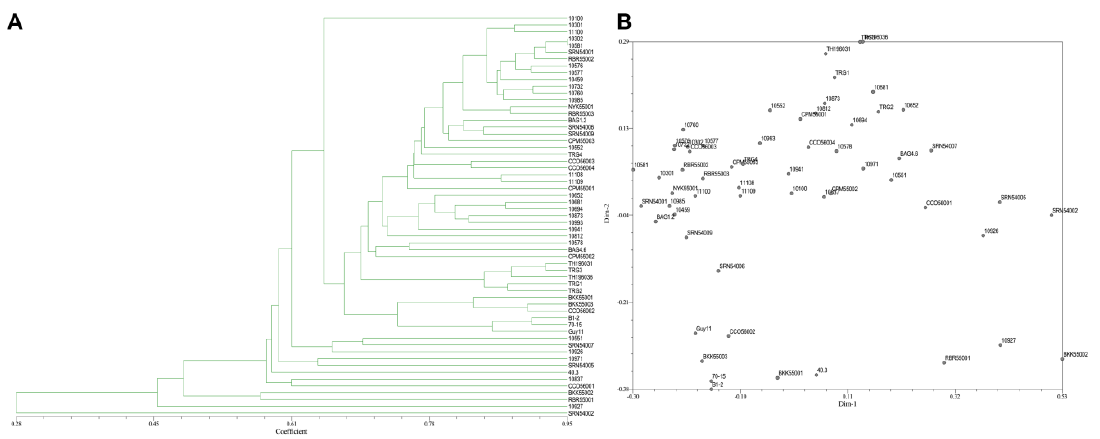
Figure 7. ( A ), Dendrogram presenting the relationship from ISSR markers and SRAP markers based on UPGMA cluster analysis. ( B ), 2D principal component analysis (PCA) based on genetic relationships from ISSR and SRAP data using the DECENTER and EIGEN features of NTSYSpc.